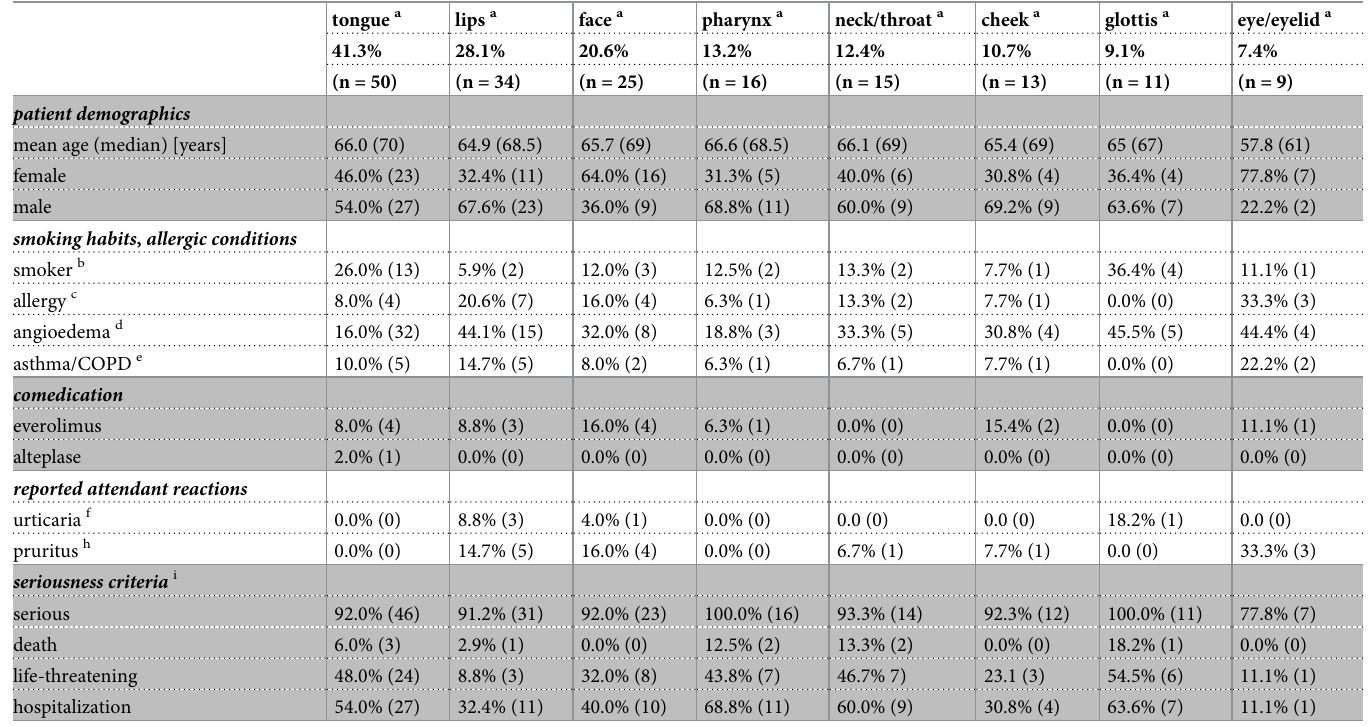
Table 3. BfArM’s ADR-database analysis: Stratified analysis of anatomical areas affected by ACEi-associated angioedemas.